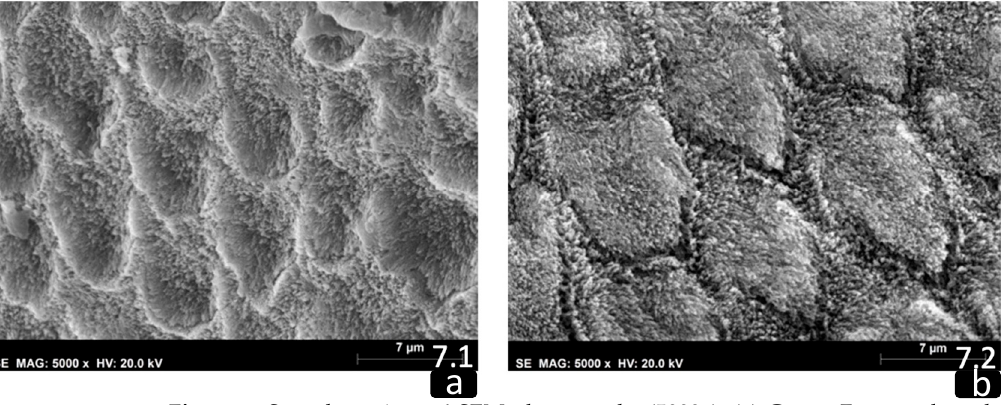
Figure 7. Sound specimens’ SEM photographs (5000×). ( a ) Group F—sound tooth; ( b ) Group I— sound tooth after CPP-ACP protocol.